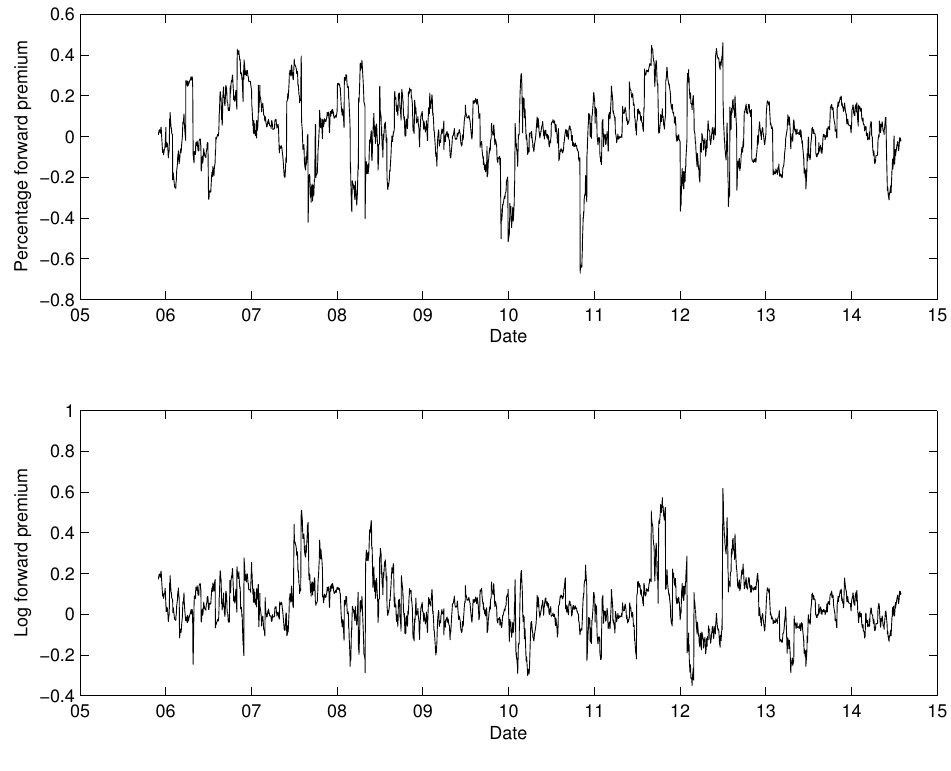
Figure 3. Logarithmic and percentage forward premium.